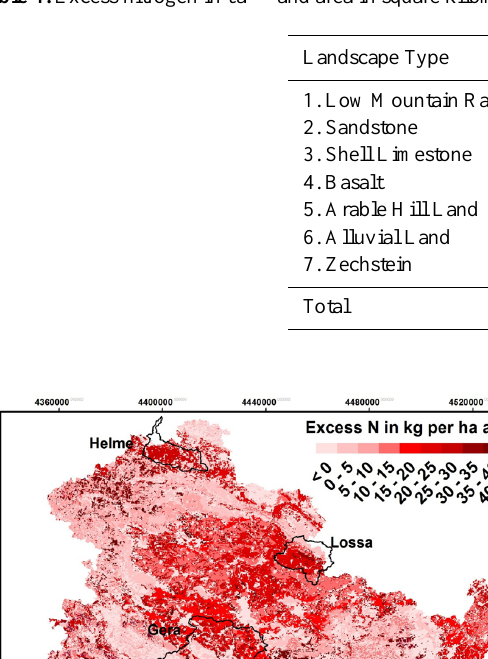
Table 4. Excess nitrogen in ta − 1 and area in square kilometers of the landscape types of Thuringia.